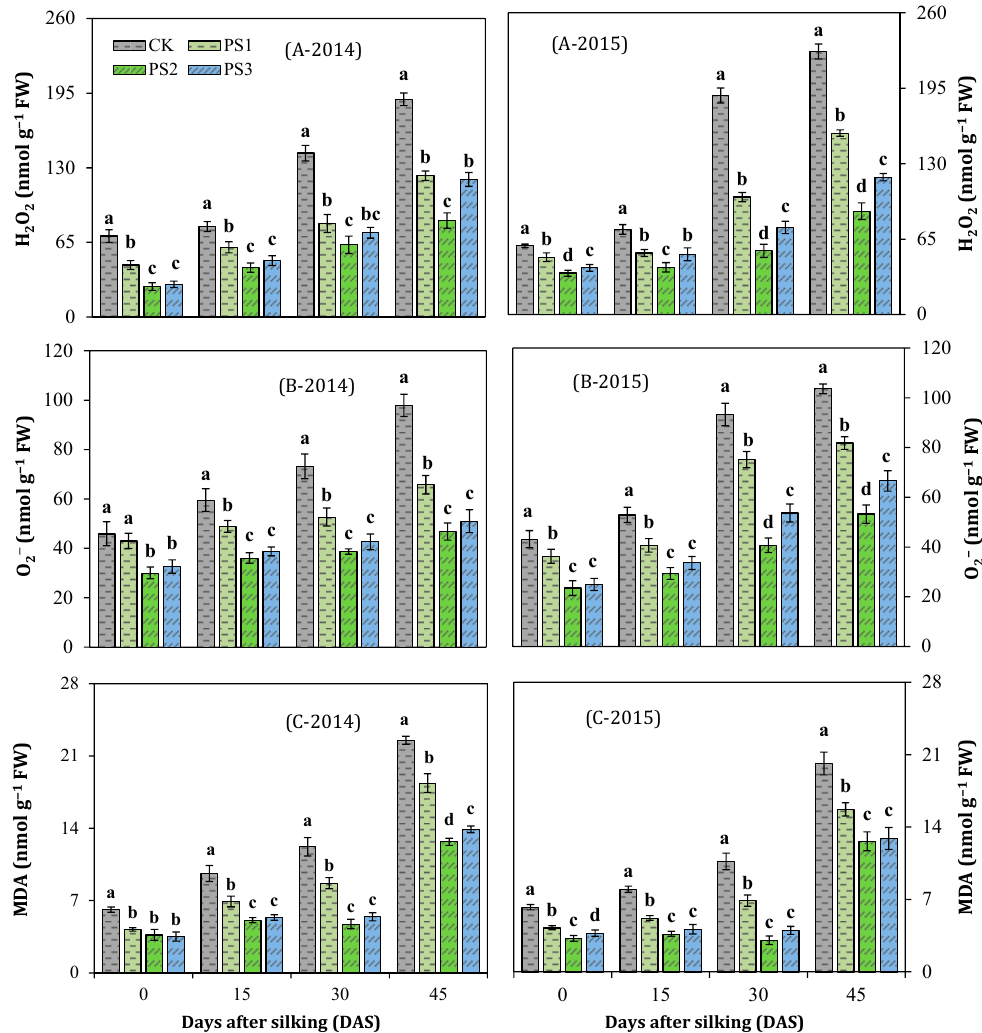
Figure 8. Effects of paclobutrazol treatments on ( A ) hydrogen peroxide, H 2 O 2 , ( B ) superoxide radical, O 2 − , and (C) malondialdehyde, MDA, contents in maize leaves during 2014 and 2015. Data are presented as mean ± SD of three measurements. Different small letters on the bars indicate significant differences at P < 0.05 (LSD test). The abbreviations of treatment names are the same as those described in Figure 2.